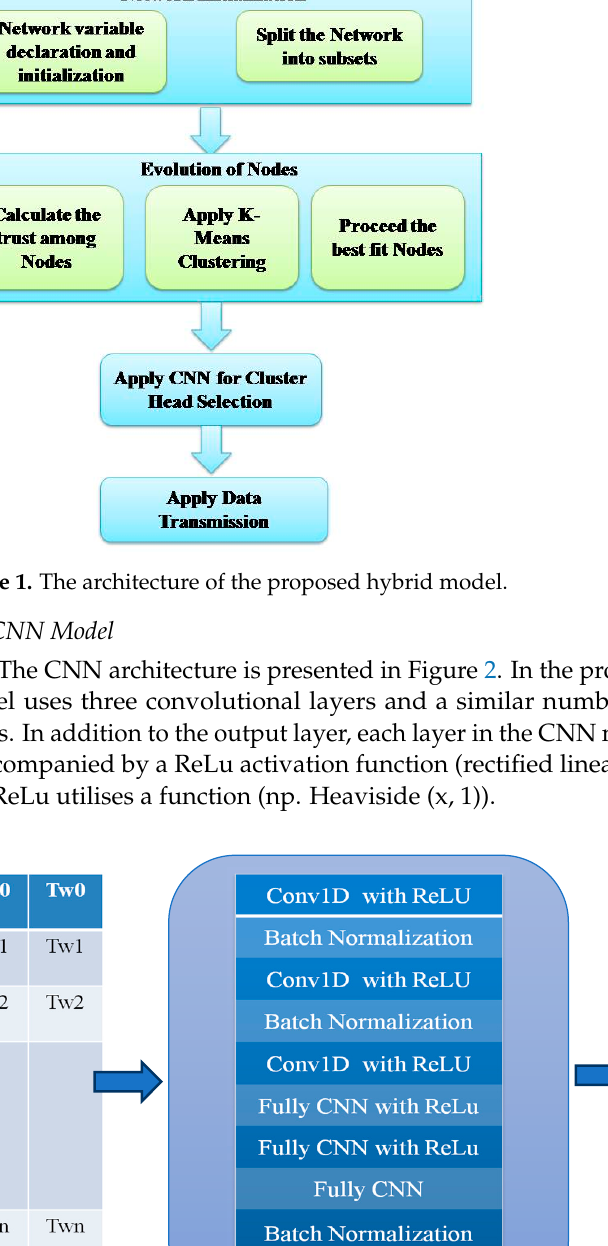
Figure 2. CNN model in Proposed Hybrid Model.